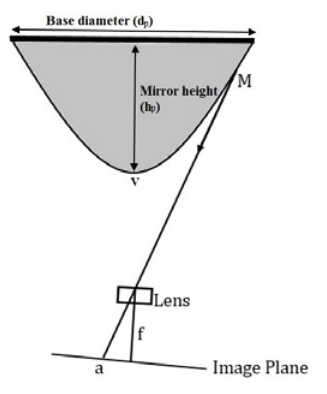
Figure 4. Mirror-Image